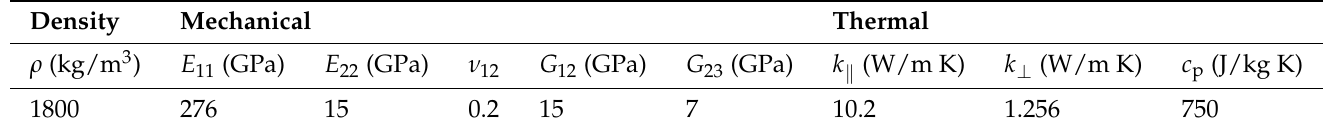
Table A2. Transversely isotropic elastic properties [25] and thermal [39] properties of the carbon fibre.